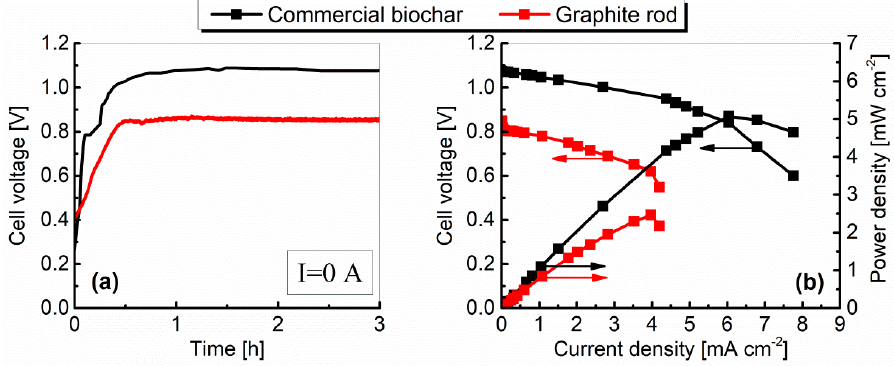
Figure 12. The variation of the fuel cell voltage vs. time ( a ) and the performance characteristics ( b ) of MH-DCFC Model I constructed from carbon steel.